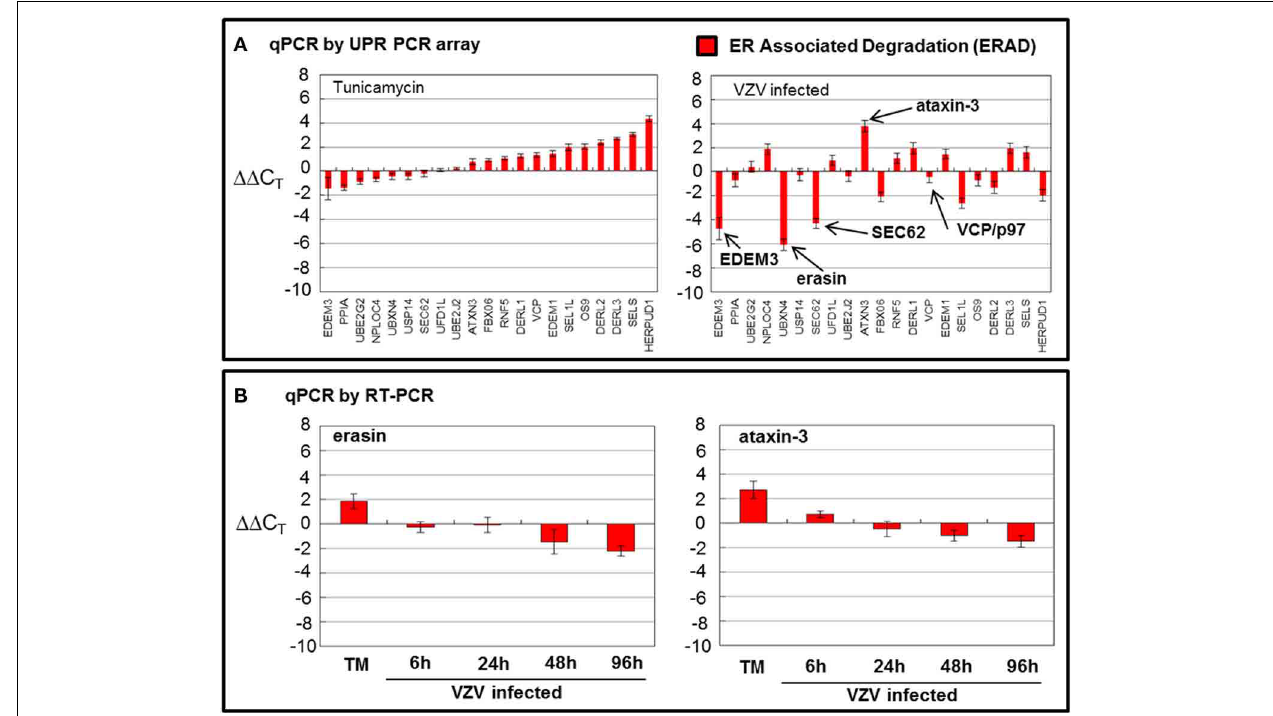
FIGURE 5 | VZV infection moderately downregulated ER associated degradation genes. Human fibroblast cells (MRC-5) were grown in tissue culture plates then infected with VZV-32 infected MRC-5 cells or treated with tunicamycin (TM), a N-glycosylation inhibitor. At 72 hpi, RNA was processed as described in the legend to Figure 2 . All gene transcription measurements were graphed for tunicamycin treated and VZV infected cell samples. (A) By measurements using the UPR specific